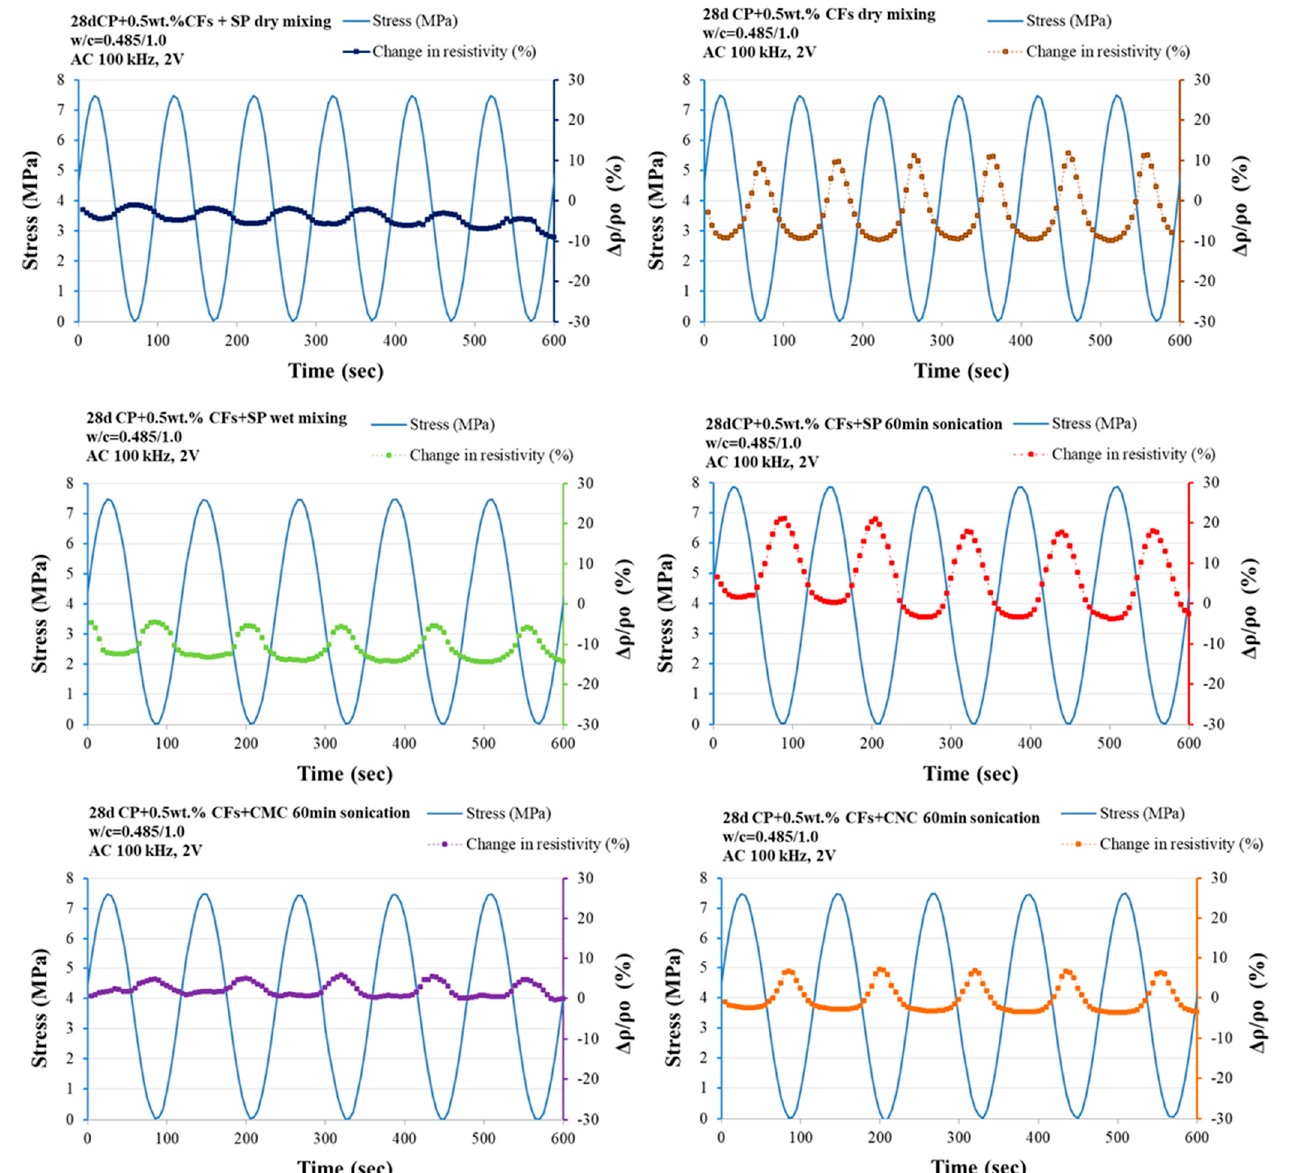
Figure 9. Piezoresistivity response of 28-day plain and reinforced cement paste composites with CFs incorporated by different methods. Table 2. Electrical resistivity values and average change in resistivity Δρ / ρ 0 (%) of 28-day plain and cement paste micro-composites reinforced with CFs.